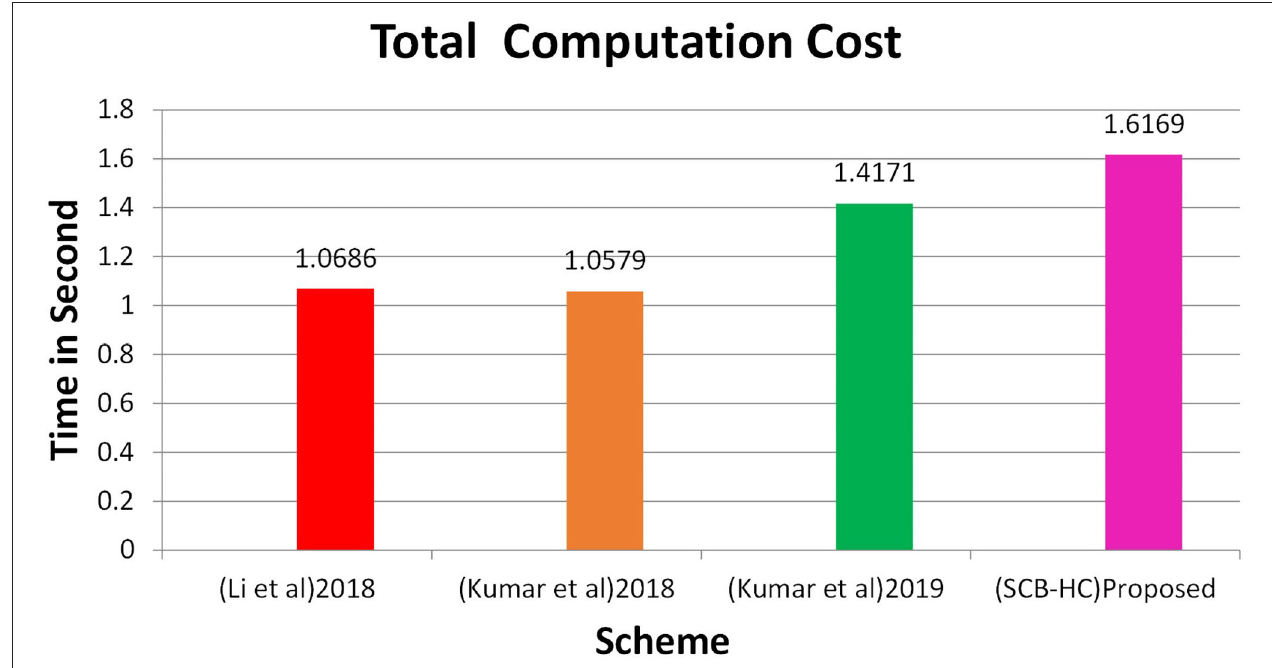
FIGURE 6 | Total computation cost.